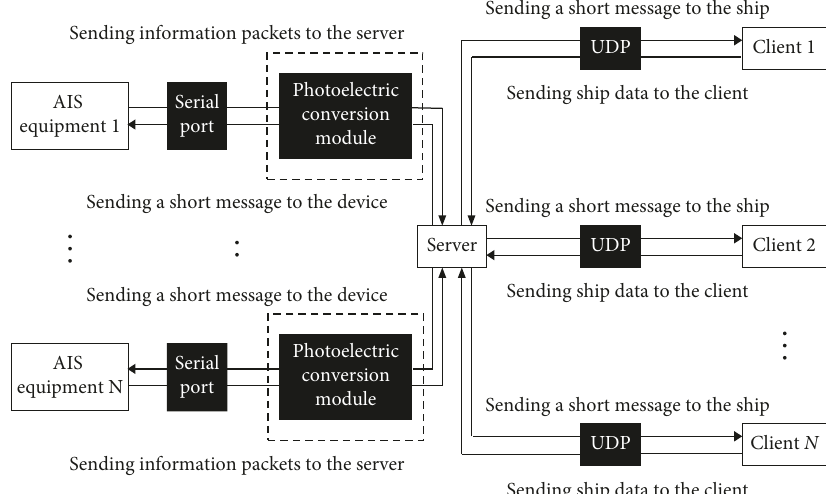
Figure 1: Flow diagram of the system